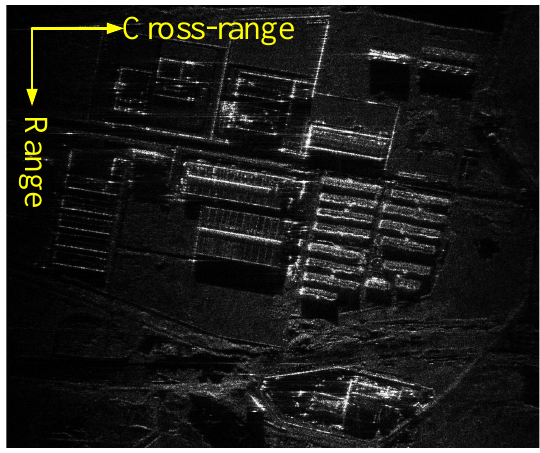
Figure 7. The stationary scene image after eliminating the energy of T1.